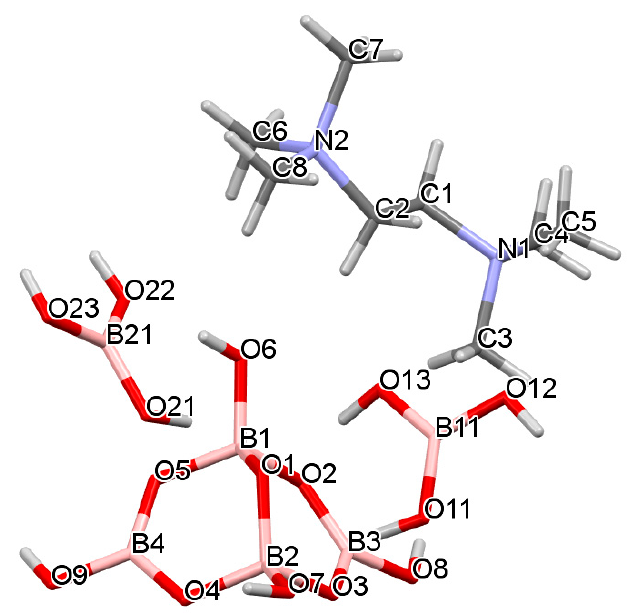
Figure 5. Drawing of the structure of 9 showing atomic labelling. Two water molecules (containing O31 and O32) are omitted for clarity. Compound 9 is disordered and only components with highest s.o.f are shown.